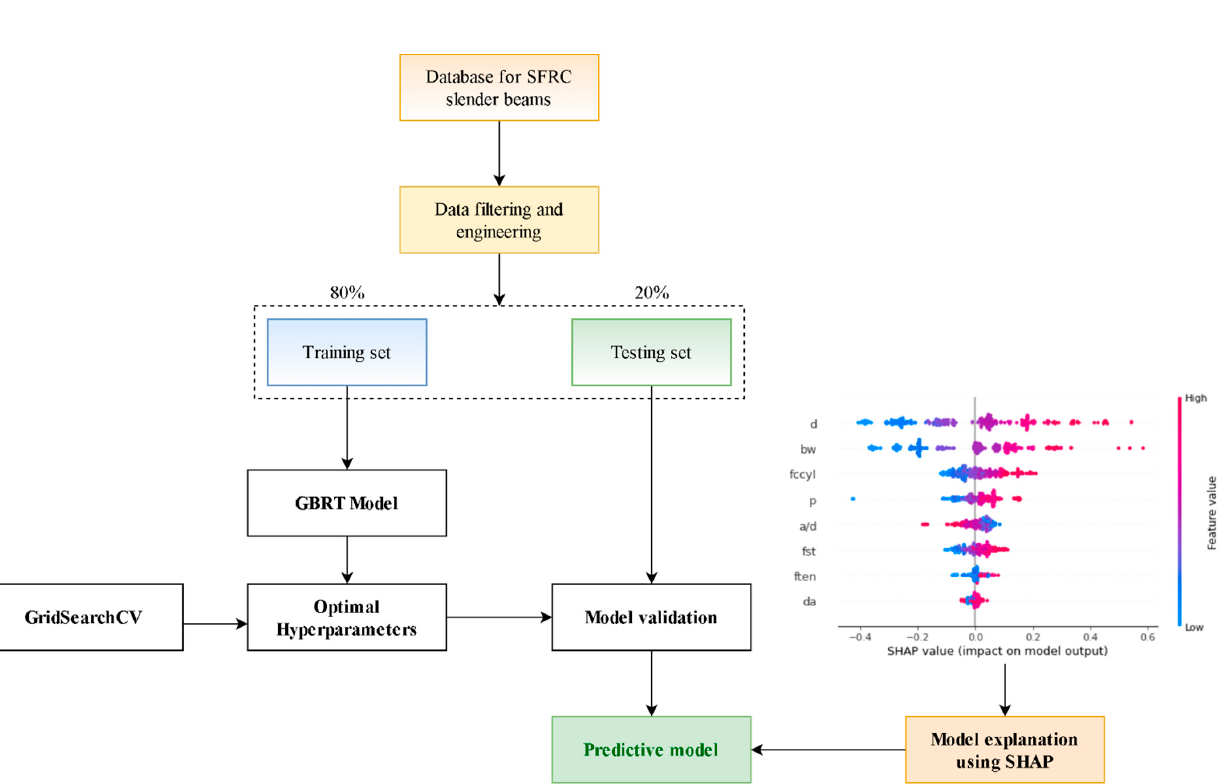
Figure 1. Workflow used to develop the explainable ML model. Table 1. Statistical measures of the